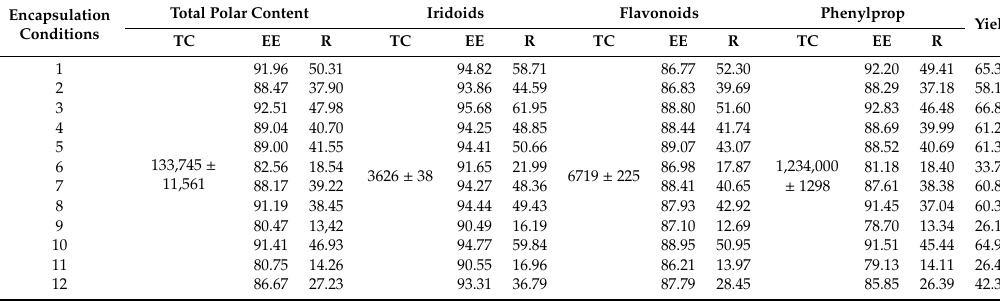
Table 1. Responses of spray drying process in MD particles.